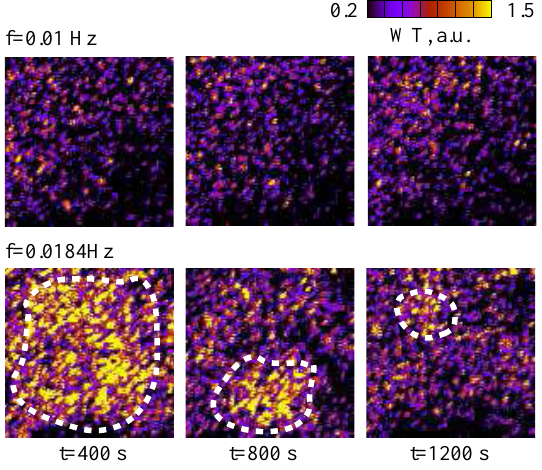
Fig. 6. The representative snapshots of WT power of the kidney segment recorded at f ¼ 0 : 01 Hz (slow unspeci¯ed rhythm) and at f ¼ 0 : 0185 Hz (TGF regulation). Dashed con- tour outlines the localized area of pronounced TGF rhythm. The time distance between frames corresponds to 8 – 9 TGF periods. N A ¼ 1.